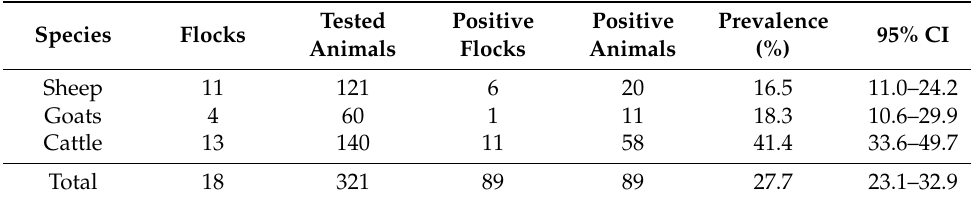
Table 1. Serological analysis of the ruminant blood samples for Batai virus (BATV) with serum neutralization test (SNT).